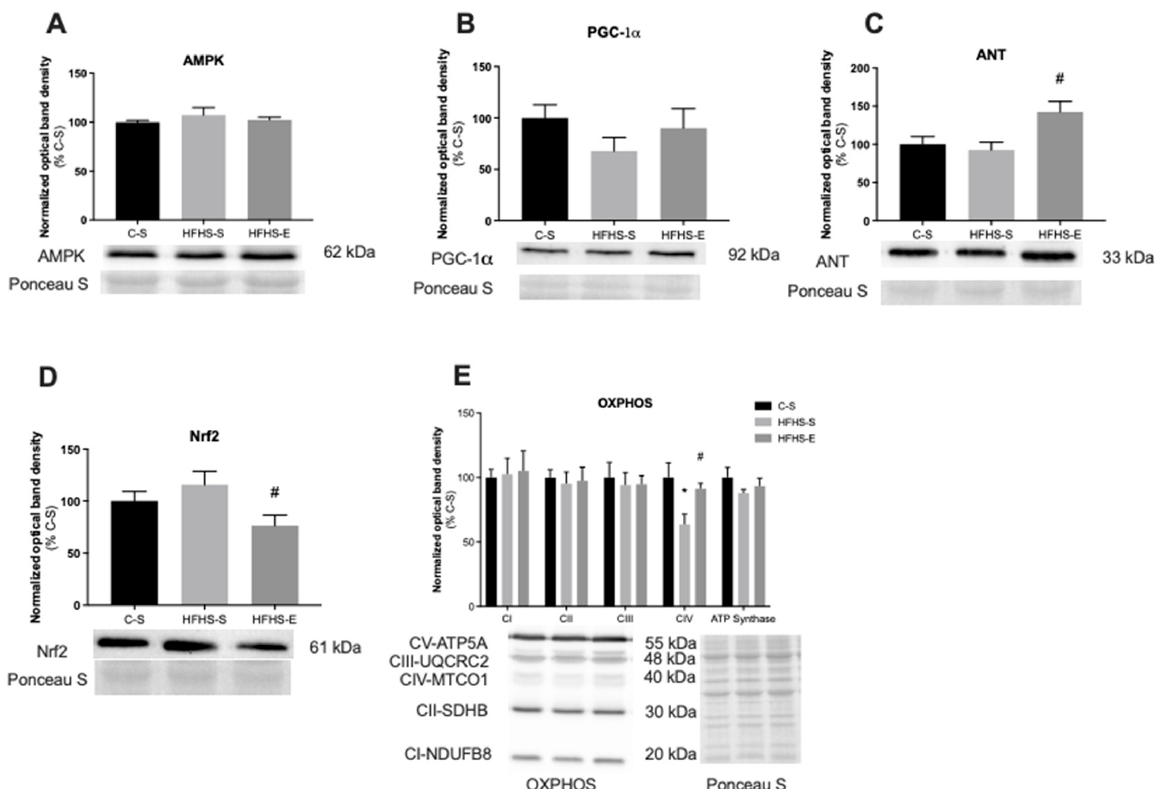
Figure 5. Relative protein content of 5 ′ adenosine monophosphate-activated protein kinase (AMPk) ( A ); peroxisome proliferator-activated receptor- γ coactivator-1 α (PGC-1 α ) ( B ); and adenine nucleotide translocator (ANT) ( C ). Nuclear factor-erythroid factor 2-related factor 2 (Nrf2) ( D ) and oxidative phosphorylation subunits (OXPHOS) ( E ) in the tibialis anterior muscle. Offspring from the control diet sedentary group (C–S); offspring from the high-fat, high-sucrose diet sedentary group (HFHS–S); offspring from the high-fat, high-sucrose diet exercised group (HFHS–E), n = 6. Data are expressed as the mean ± SEM. Statistically significant differences ( p ≤ 0.05) are indicated as follows: * vs. C–S, # vs. HFHS–S.